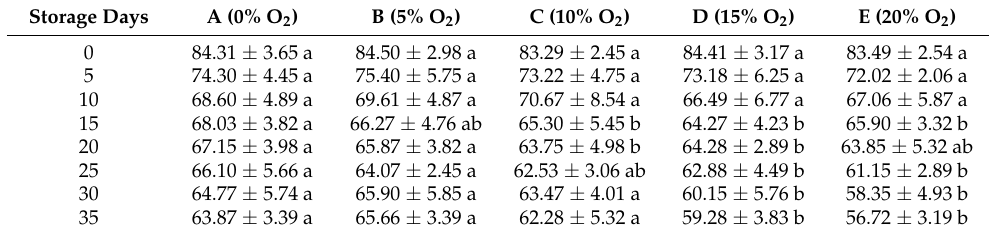
Table 2. Changes in the Haugh unit of eggs at different oxygen (O 2 ) concentrations during